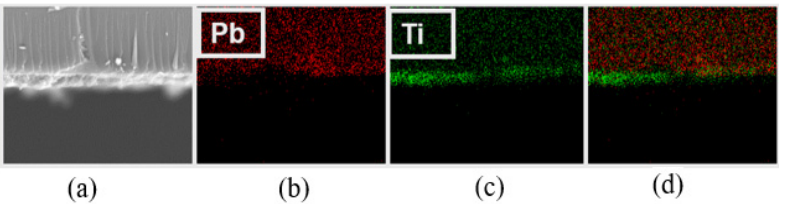
Figure 4. EDS images of Pb and Ti in the CH 3 NH 3 PbI 3 /TiO 2 composite thin film prepared from Pb:Ti of 1:2 . (a ) characterization region; ( b ) Pb; ( c ) Ti; ( d ) Pb and